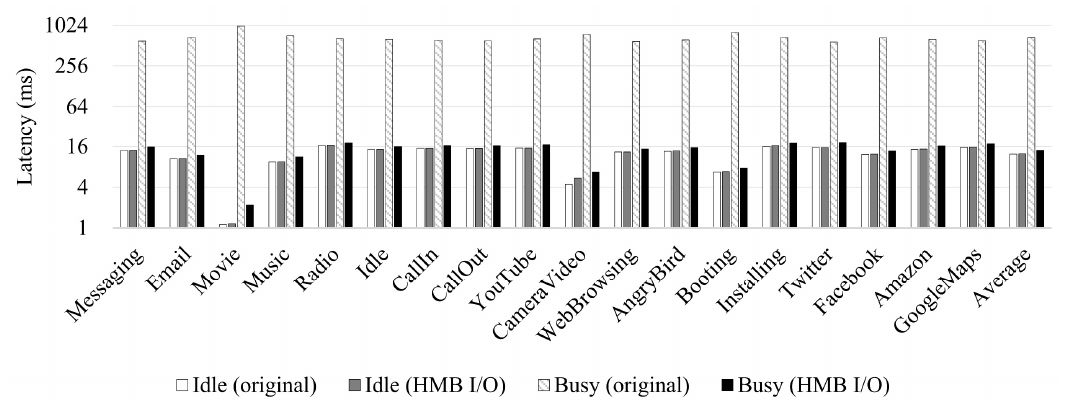
Figure 7. Average latency of urgent I / O requests.